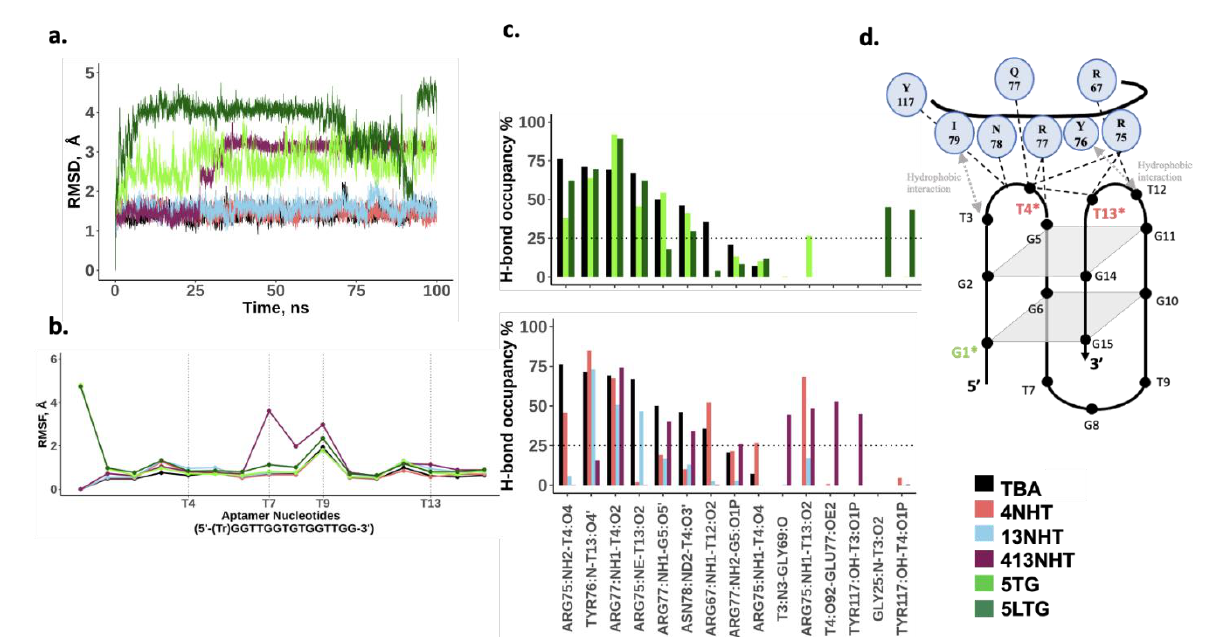
Figure 6. MD simulation results for the thrombin bound aptamers. ( a ) Root mean square deviation from the initial structure; ( b ) Average root mean square fluctuations for each nucleotide in the native and modified aptamer. Trebler group is treated as a separate nucleotide; ( c ) Bond occupancies for inter-hydrogen bonds of the aptamer with thrombin. Only H-bonds with at least 25% occupancies are shown; ( d ) Schematic of the various interactions between the aptamer and thrombin.